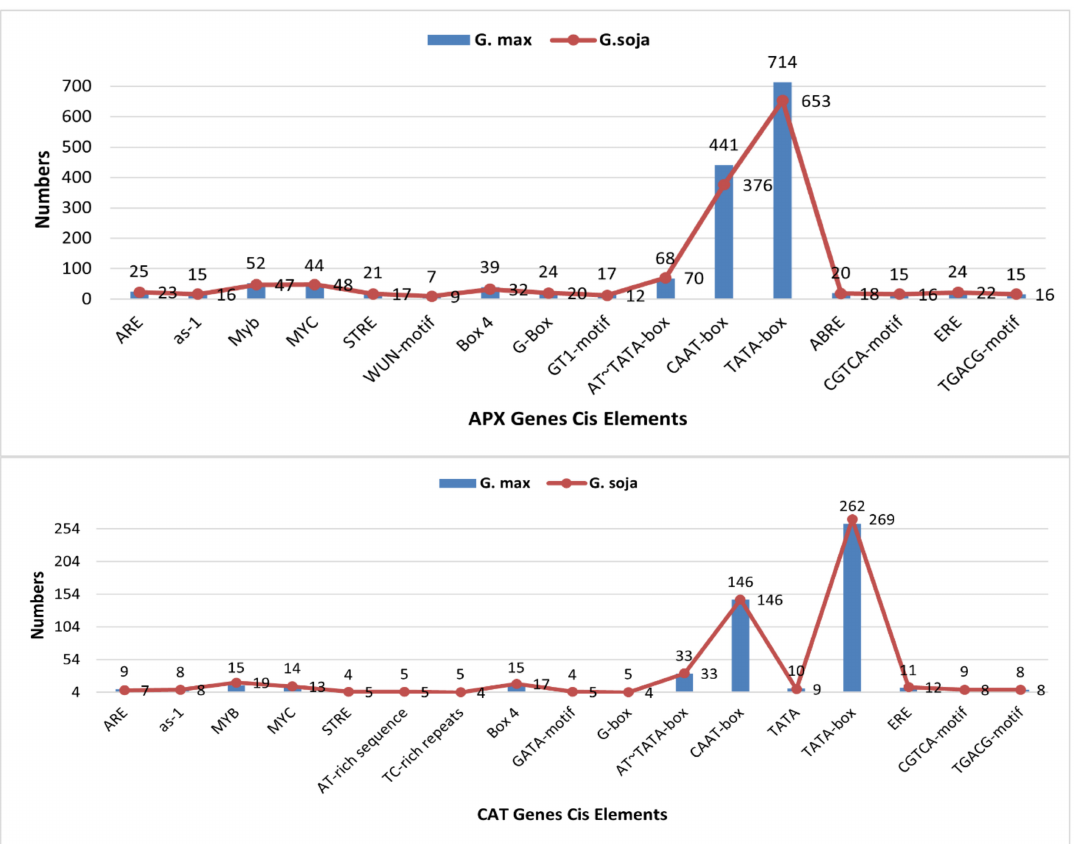
Figure 3. An overview of cis regulatory elements in APX and CAT gene family members of G. max and G. soja . The blue bars represent the cis-element values for cultivated soybean ( G. max ), whereas the red points within the red line represent the cis-element values for wild soybean ( G. soja